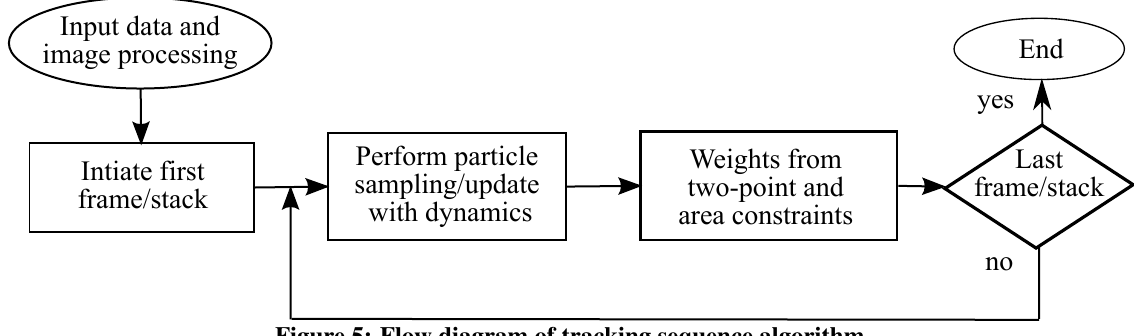
Figure 5: Flow diagram of tracking sequence